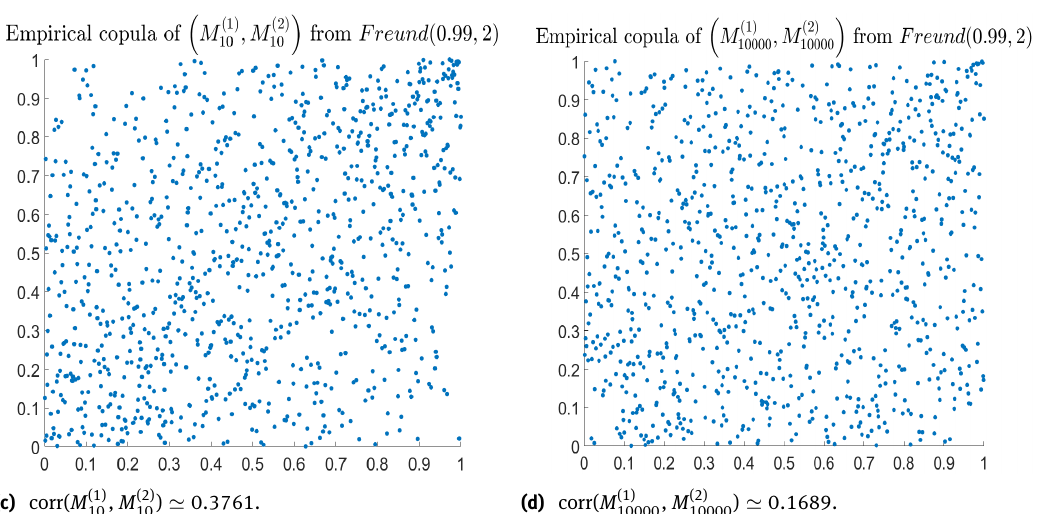
Figure 3: Scatterplots of componentwise maxima for a = 0.99